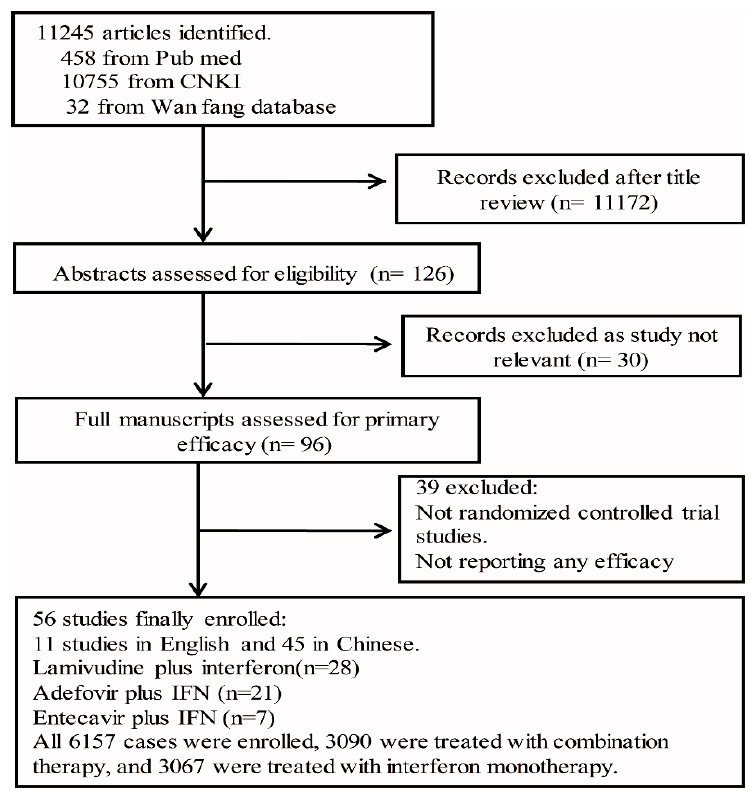
Figure 1. Flow chart of study selection and extraction.